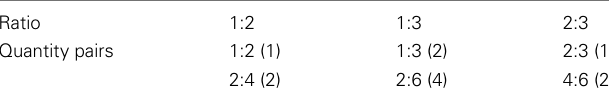
Table 1 | Quantity pairs used in the experiment, grouped by the ratios.